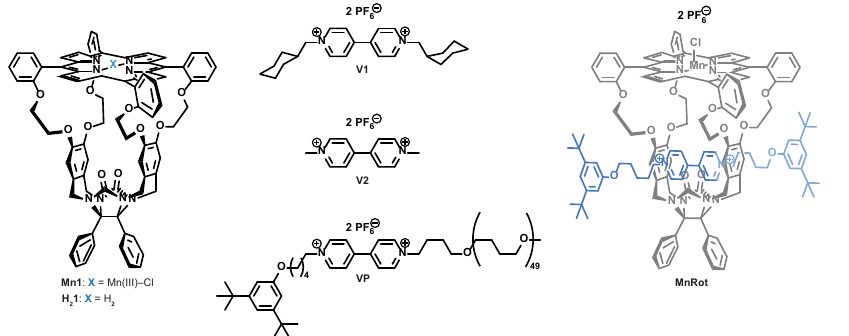
Fig. 1 Molecular structures of the studied compounds. Mn(III)-porphyrin cage compound Mn1 (porphyrin center atom(s) indicated in blue), bis-(methyl cyclohexyl) viologen V1 , methyl viologen V2 , polymer-substituted viologen VP , and the rotaxane of a blocked viologen guest (blue) with Mn1 ( MnRot